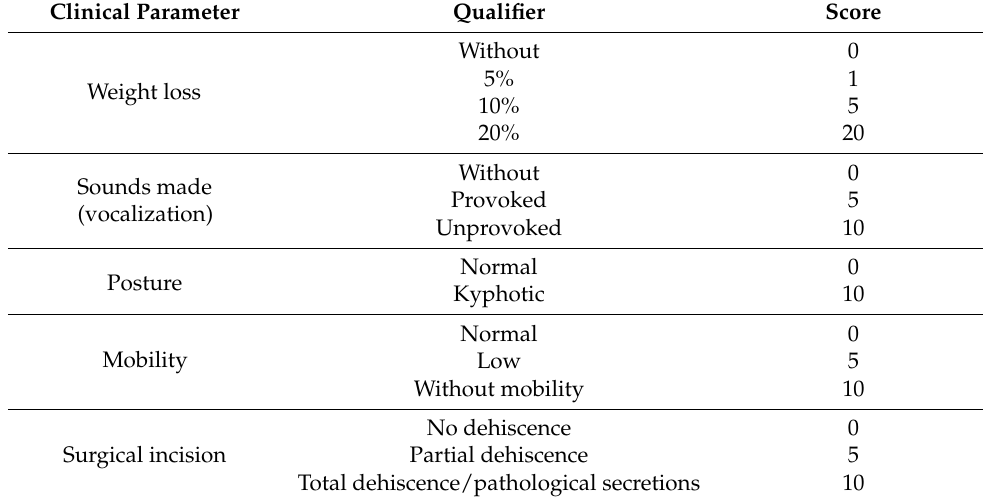
Table 2. FELASA clinical assement of the cases [17].